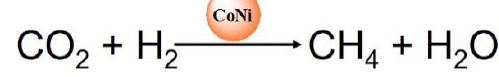
Figure 8. CoNi@C 0.2g, flow of mixture = 15 mL, mixture (H 2: CO 2 ) = 3:1, T = 375 °C, 30 bar. 3. Experimental 3.1. Materials and General Methods 3.1.1. Chemicals used in This Work Trimesic acid (98% purity) (TPA), Nickel nitrate hexahydrate (99.99% purity) (Ni(NO 3 ) 2 ·6H 2 O), Cobalt nitrate hexahydrate (99.99% purity) (Co(NO 3 ) 2 .6H 2 O) methanol (99.9% purity), N , N -dimethylformamide (DMF; 99.8% purity), Acetic acid (CH 3 COOH) (99.0%) dichloromethane (99.8% extra-dry grade), o -Phenylenediamine (99.5%) with all the other derivatives of the aromatic diamines were purchased from Sigma Aldrich Corporation. NMR solvents: dimethyl sulfoxide- d 6 (DMSO- d 6 ; 99.9% purity) were purchased from Cambridge Isotope. All chemicals were used without further purification. Water used in this work was double-distilled and filtered through a Millipore membrane.